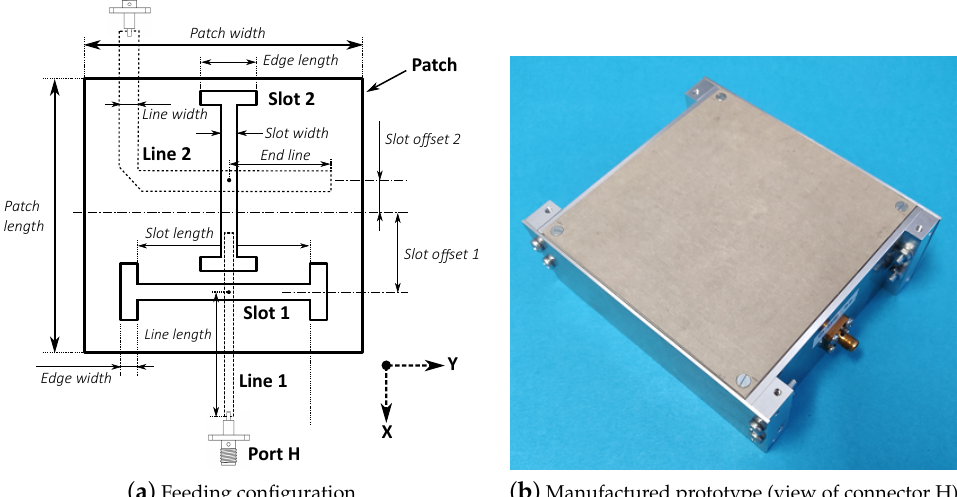
Figure 3. Antenna feeding layout and constructed